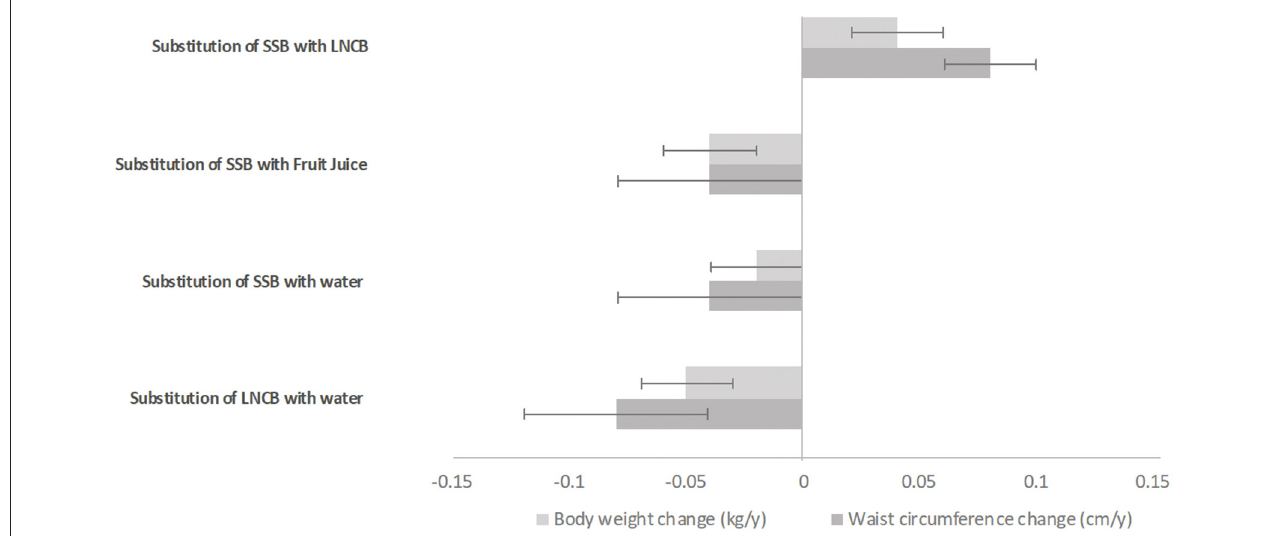
FIGURE 3 | Adjusted substitution associations of one serving of beverage with another with body weight change (kg/year) and waist circumference change (cm/year) in the Lifelines Cohorts Study; Models were adjusted for age, sex, height, baseline weight or baseline waist circumference (for models with waist circumference as outcome), education, alcohol intake, smoking, physical activity, all dietary factors and history of diseases. Error bars represent the 95% CIs. SSB, sugar-sweetened beverages; LNCB, low/no-calorie beverages.